Question: From the figure, is the trend upward or downward?
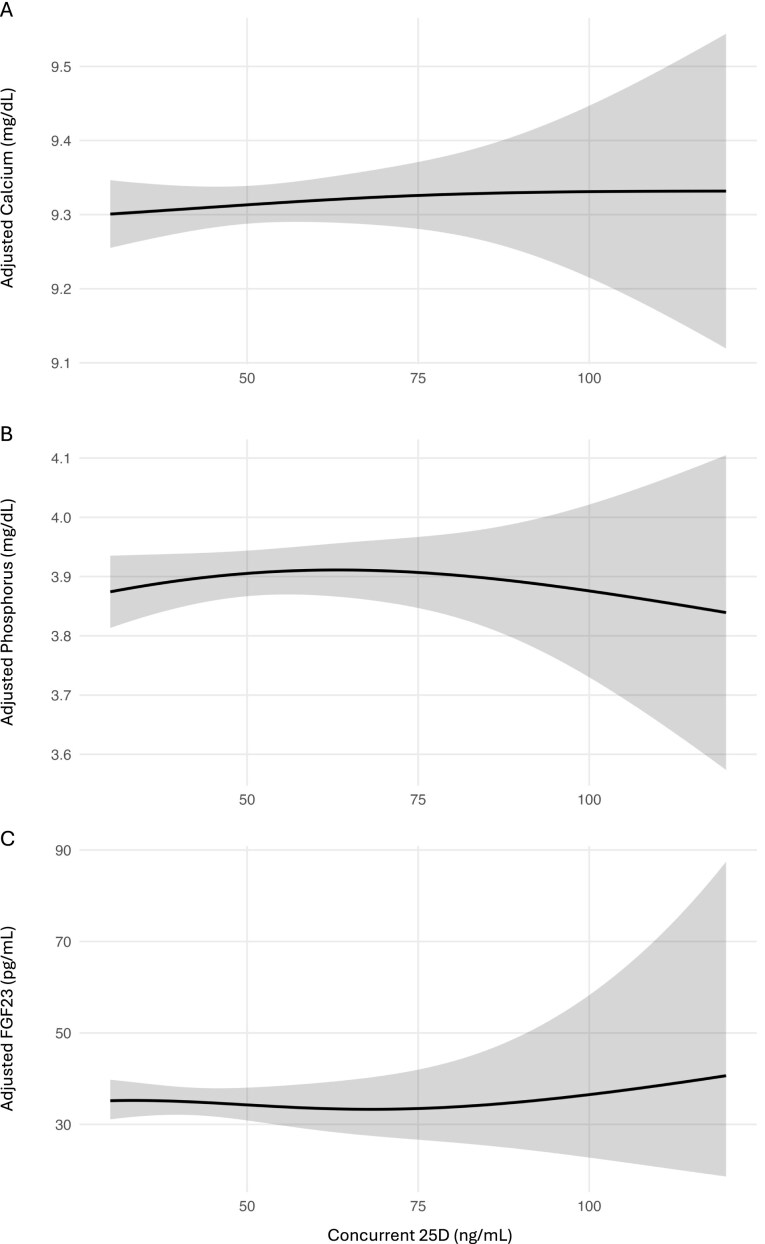
Answer: increasing